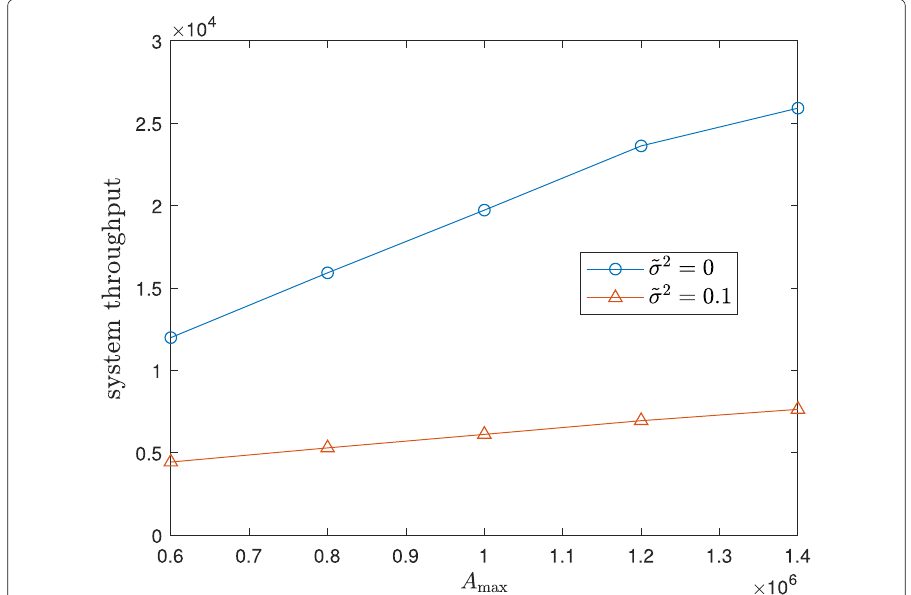
Fig. 5 The effect of average data arrival rate A max on system